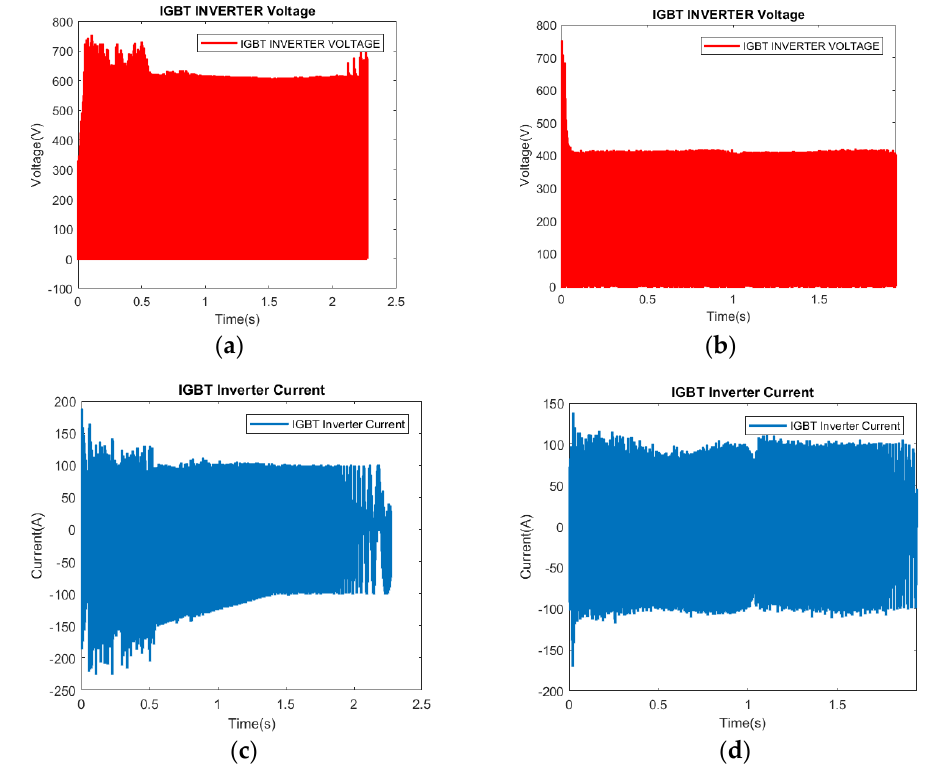
Figure 18. Voltage stress applied to inverter IGBT modules for the ( a ) MCBC 3rdH modulated inverter, ( b ) SVPWM inverter, as well as the current flowing through, respectively ( c , d ).